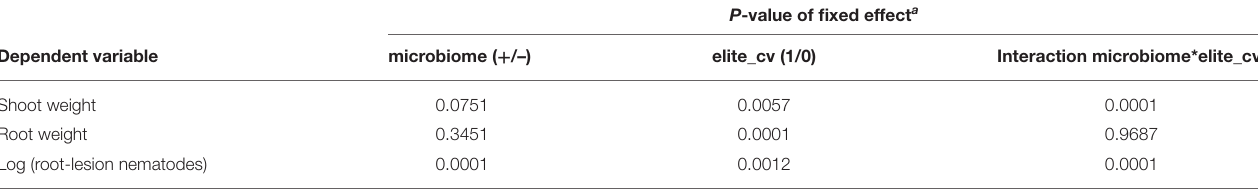
TABLE 1 | Generalized linear mixed models (GLMM) for microbiome-dependent responses of elite cultivars and ancestral genotypes of barley.